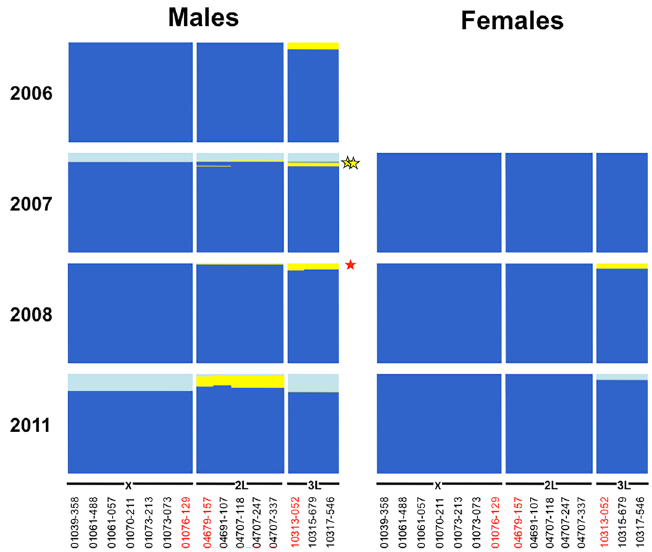
Figure 1. DIS map of males and females Anopheles coluzzii and An. gambiae collected from swarms in the village of Somousso in Burkina Faso—DIS genotypes, specific to An. coluzzii (light blue) and An. gambiae (dark blue) are shown; herozygous DIS genotypes are in yellow—SNPs nearest to centromeres are in red lettering. One F 1 hybrid male with An. gambiae maternal X-island was identified in 2008 (red star) and 2 males captured in 2007 were characterized by an An. coluzzii X-islands but An. gambiae 2L and 3L islands (yellow